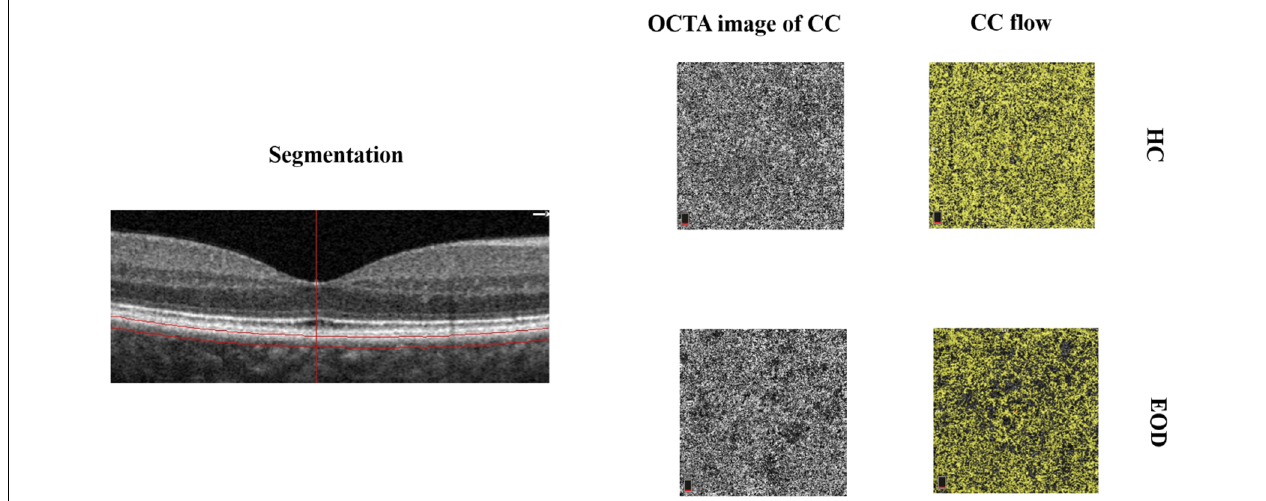
FIGURE 1 | Segmentation and representative image of the choriocapillaris (CC). The choriocapillaris is the microvessels within the Bruch’s membrane and the upper boundary of the stroma. Early-onset dementia (EOD) showed interrupted choriocapillaris in the optical coherence tomography angiography (OCTA) image. The CC flow showed reduced choriocapillaris density when compared with healthy controls.